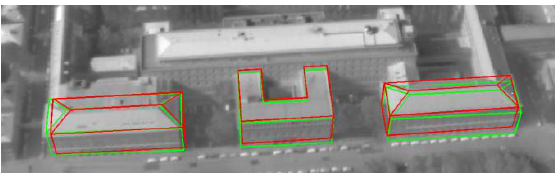
Figure 4. Correspondence selected using MRF. In Fig. 5 the projected model before (green) and after projection (red) are displayed.